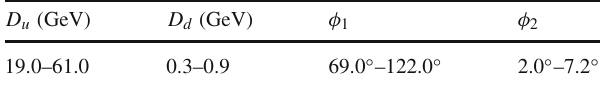
quark mass matrices given in Eq.